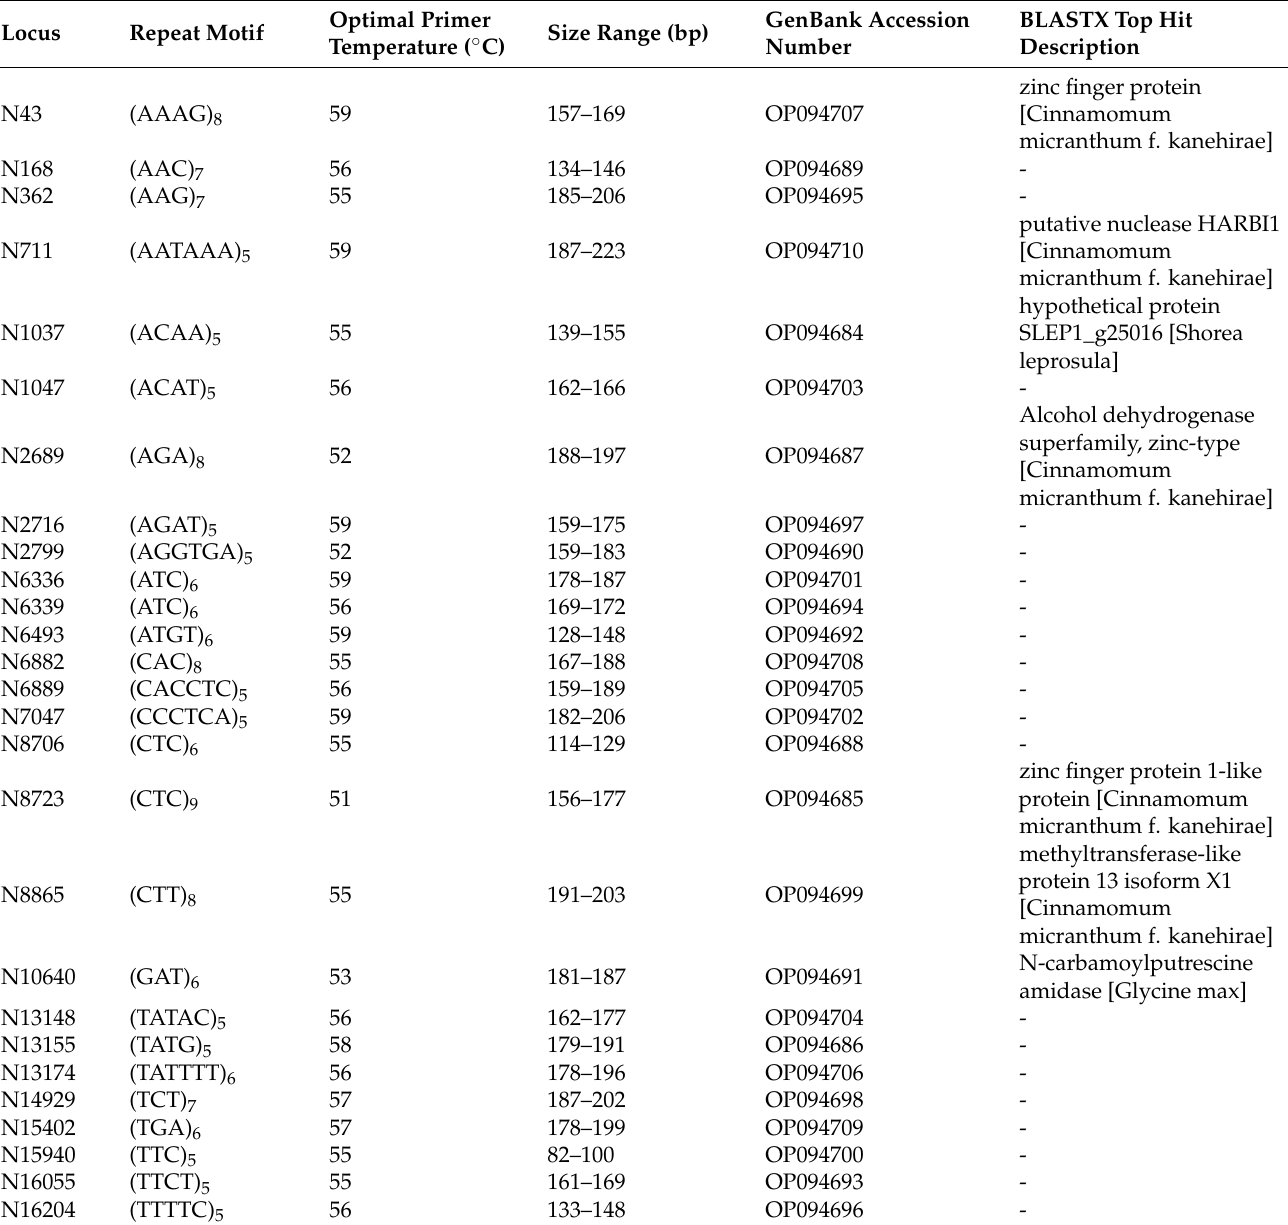
Table 1. Characteristics of 27 newly developed nSSR loci of S. tzumu in this